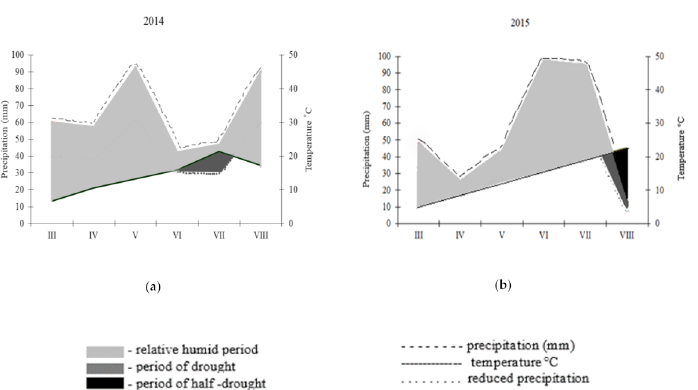
Figure 1. Climatic data characterizing weather conditions in Przeb˛edowo, Poland in the experimental area during growing seasons ( a ) 2014 and ( b ) 2015 prepared according to Walter